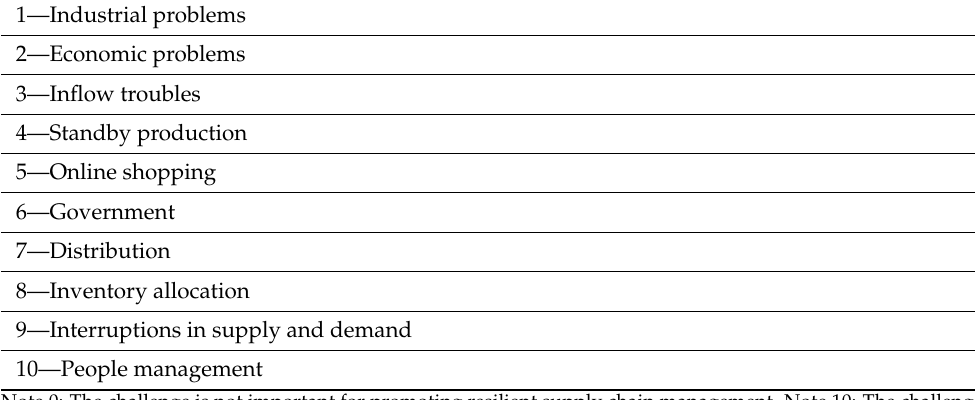
Table 3. Overview of the survey